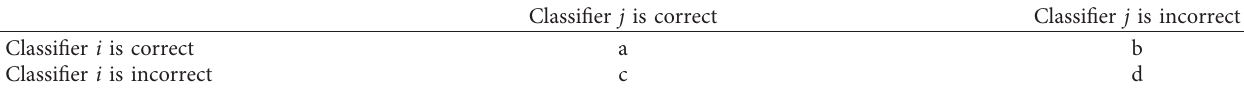
Table 2: Reference for pairwise diversity metrics, from [39].